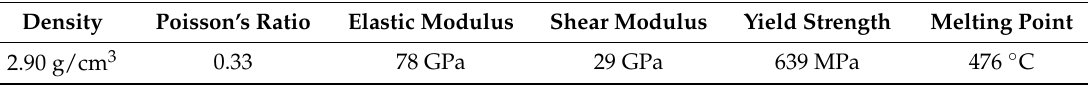
Table 4. Physical properties of in-situ TiB 2 /7050Al metal matrix composite